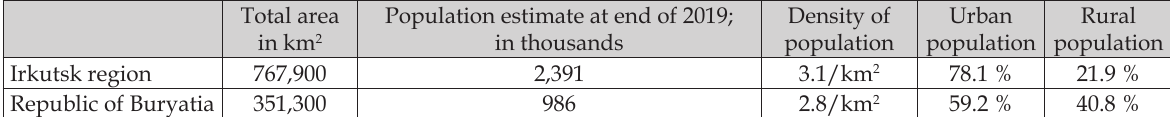
Table 3. Total area and selected population indicators in the Baikal region. Total area Population estimate at end of 2019; in km 2